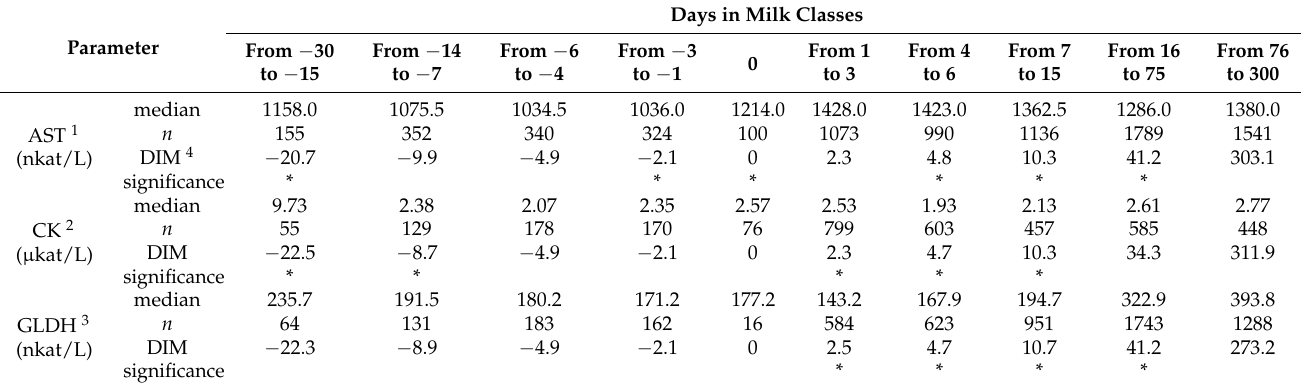
Table A3. Serum enzyme activities in ten DIM classes in primiparous cows.